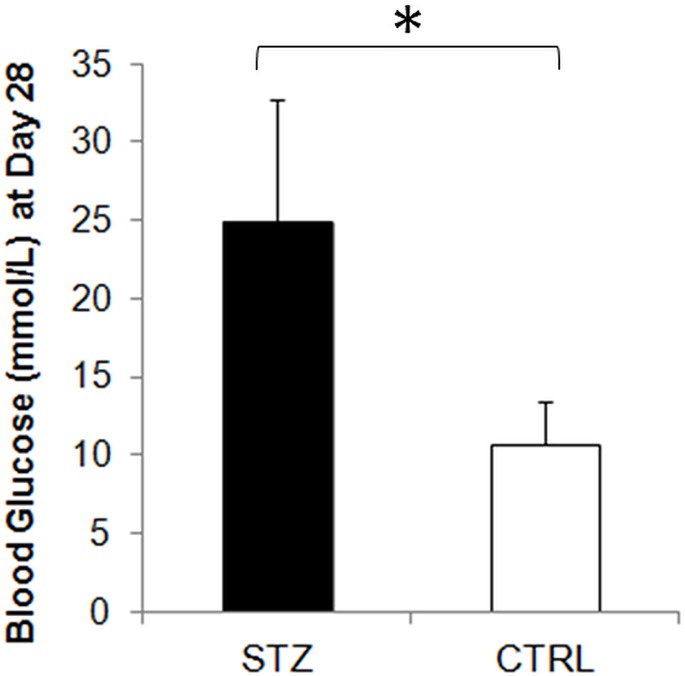
Blood glucose level at 1 month after streptozotocin (STZ) or sham control (CTRL) treatment.(Two-tailed unpaired Student’s t-test between STZ and CTRL groups, *p<0.05.)